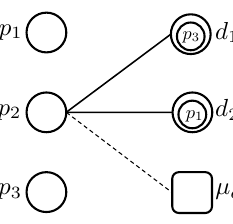
Figure 4. Example of a bipartite graph B 1 = ( U 1 , E 1 ) after an iteration of the Gale–Shapley